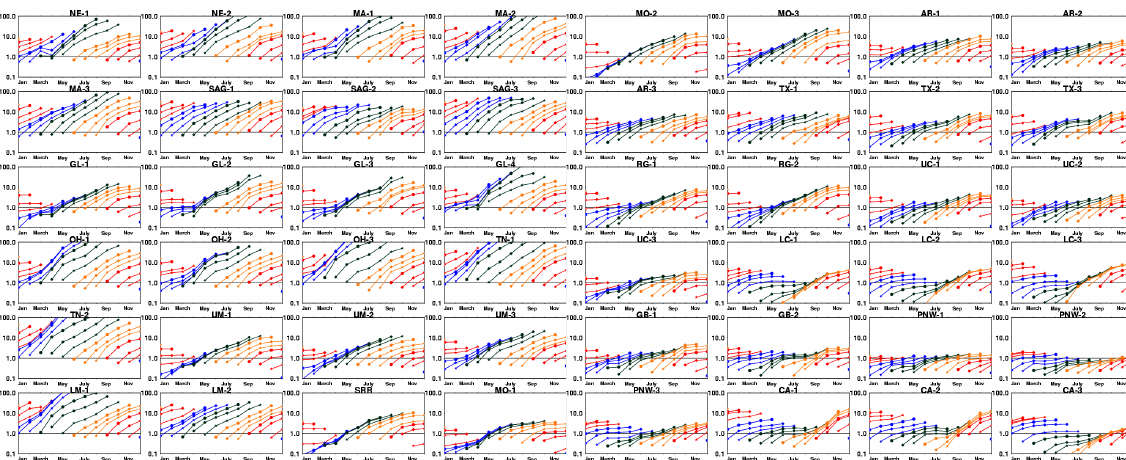
Fig. 5. Variation of RMSE ratio (i.e. RMSE ESP /RMSE revESP ) with lead time over 48 hydrologic sub-regions, for the SM forecasts at lead-1 to 6months, initialized on the beginning of the each month. (DJF: blue, MAM: green, JJA: light brown and SON: red).